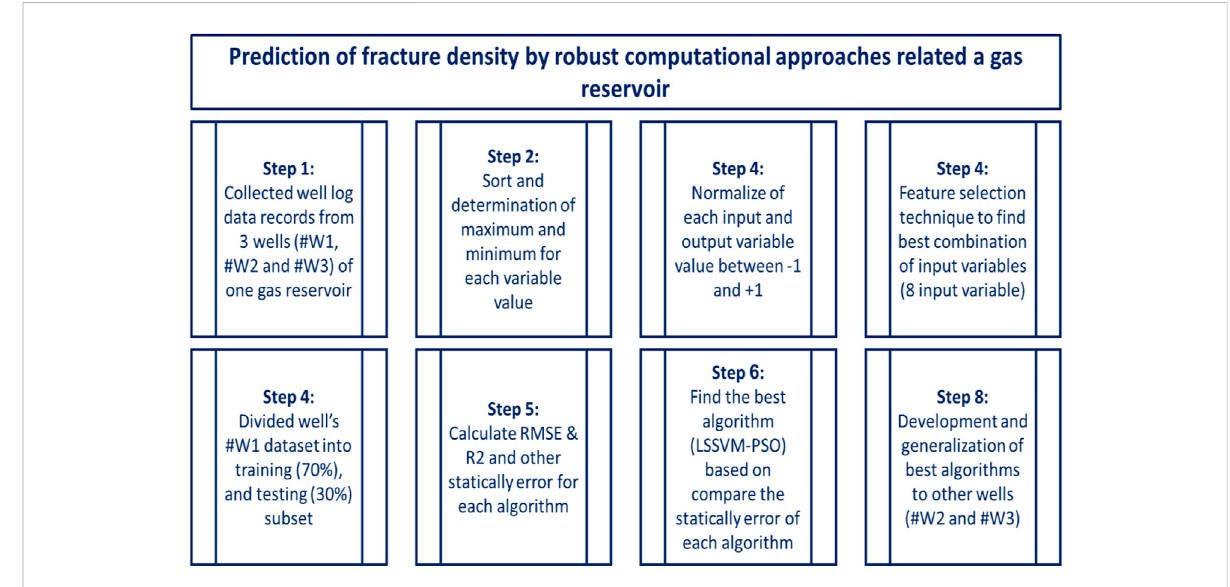
FIGURE 1 Flow diagram for work fl ow chart to develop four robust hybrid machine learning models for prediction of FVDC.